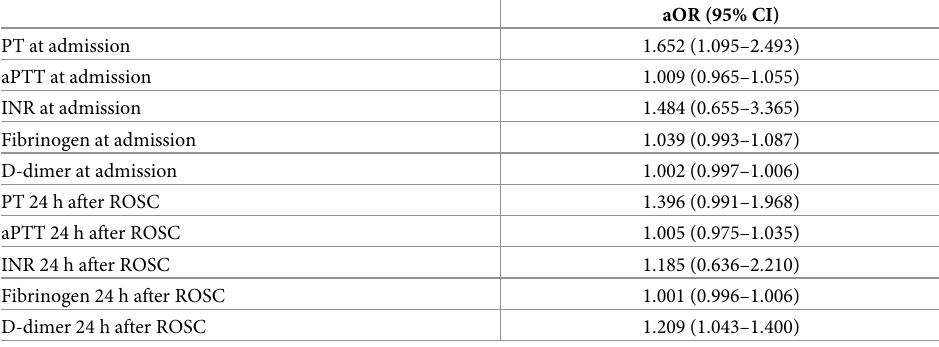
Table 2. Adjusted odds ratios of coagulation-related factors for predicting poor neurological outcome at hospital